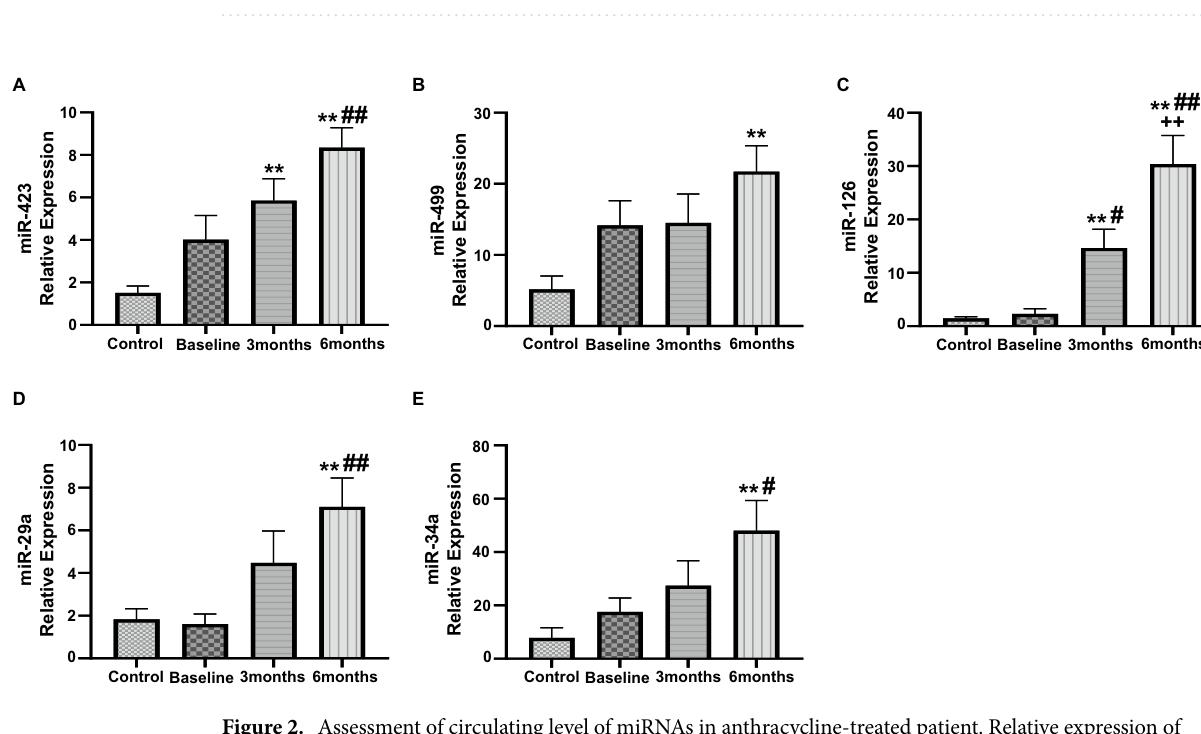
Figure 2. Assessment of circulating level of miRNAs in anthracycline-treated patient. Relative expression of circulating ( A ) miR-423, ( B ) miR-499, ( C ) miR-126, ( D ) mIR-29a and ( E ) mIR-34a, assessed by qRT-PCR analysis. Values represent means ± SEM. *p < 0.05 vs. Control, **p < 0.01 vs. Control, # p < 0.05 vs. Baseline, ## p < 0.01 vs. Baseline, + p < 0.05 vs. 3 months, ++ p < 0.01 vs. 3 months. Control (n = 17) and patients with breast cancer (n = 17) at baseline, 3 months and 6